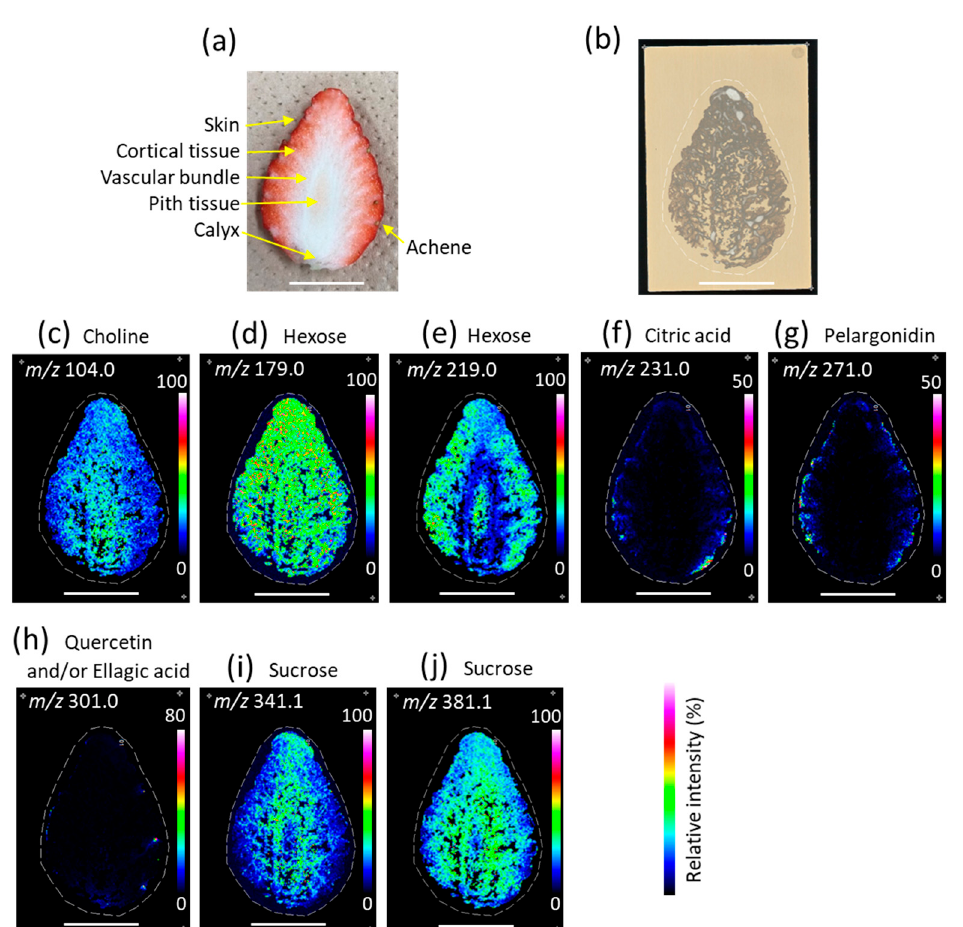
Figure 3. Visualization of the tentatively assigned metabolites in strawberry fruit. Optical images of ( a ) cross-section of strawberry fruit and ( b ) desorption ionization using through hole alumina membrane (DIUTHAME) chip blotted by the strawberry fruit. Ion images of m/z ( c ) 104.0, ( d ) 179.0, ( e ) 219.0, ( f ) 231.0, ( g ) 271.0, ( h ) 301.0, ( i ) 341.1, and ( j ) 381.1. Dotted white line indicates the analyzed region. Scale bar = 20 mm.